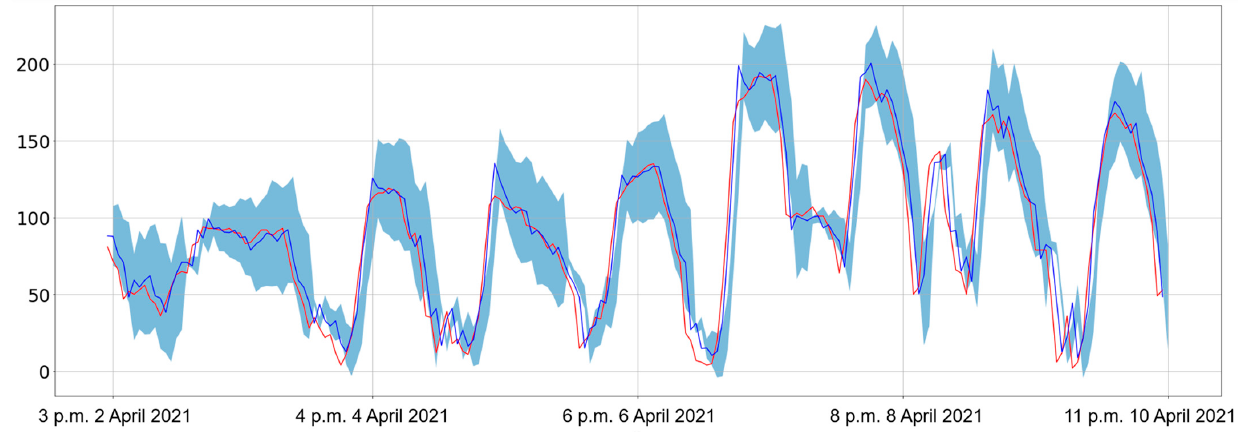
Figure 10. Forecasting results of O 3 concentration in Taian.